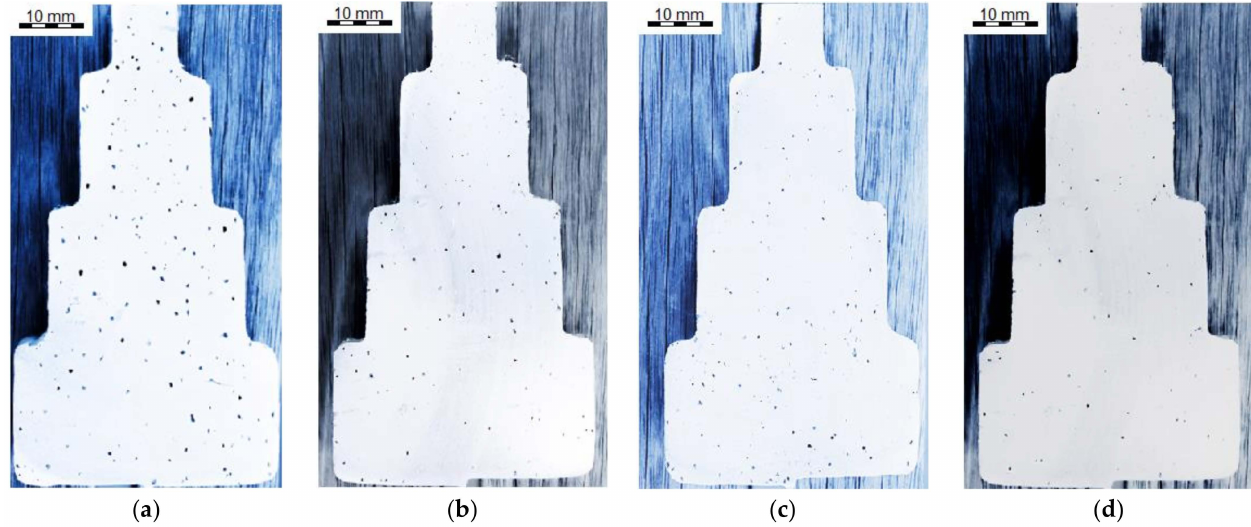
Figure 12. Porosity in specimens: ( a ) Design without foam filter; ( b ) Design with 10 ppi foam filter; ( c ) Design with 20 ppi foam filter; ( d ) Design with 20 ppi foam filter and vortex element.